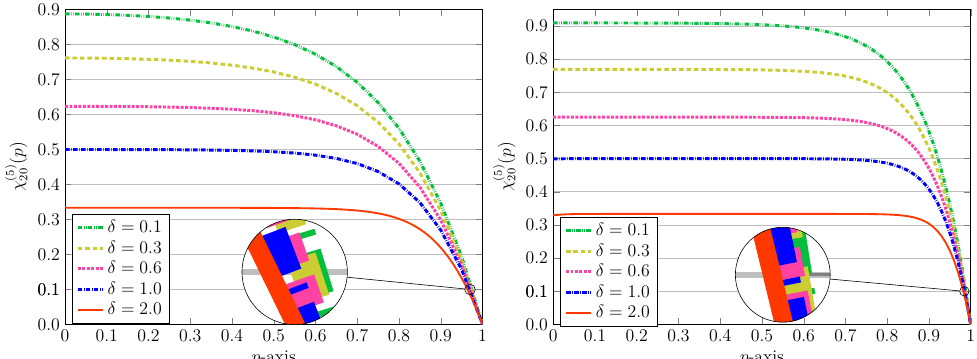
Figure 3. Graphics of numerical solution obtained via the QLM-SAPSK approach with and the associated REFs ( right ) using R = 10, various δ = 0.1,0.3,0.6,1,2, and with integer-orders θ = 2, λ = 1.